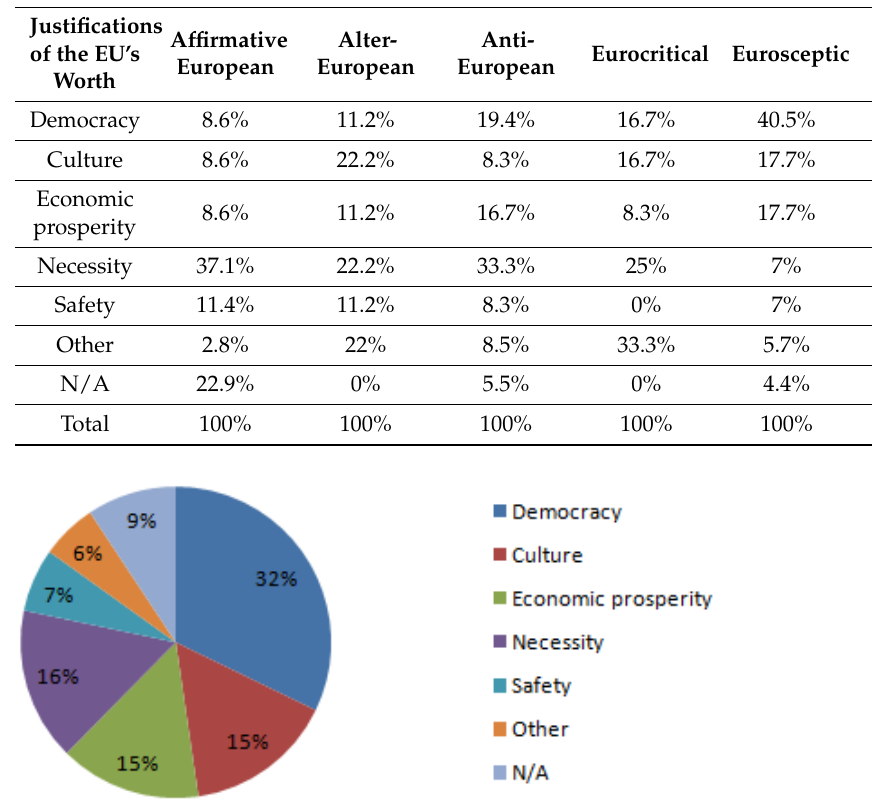
Table 3. EU polity contestation and justifications (refugee crisis). Figure 9. EU polity evaluations (n = 264). Types of Evaluation